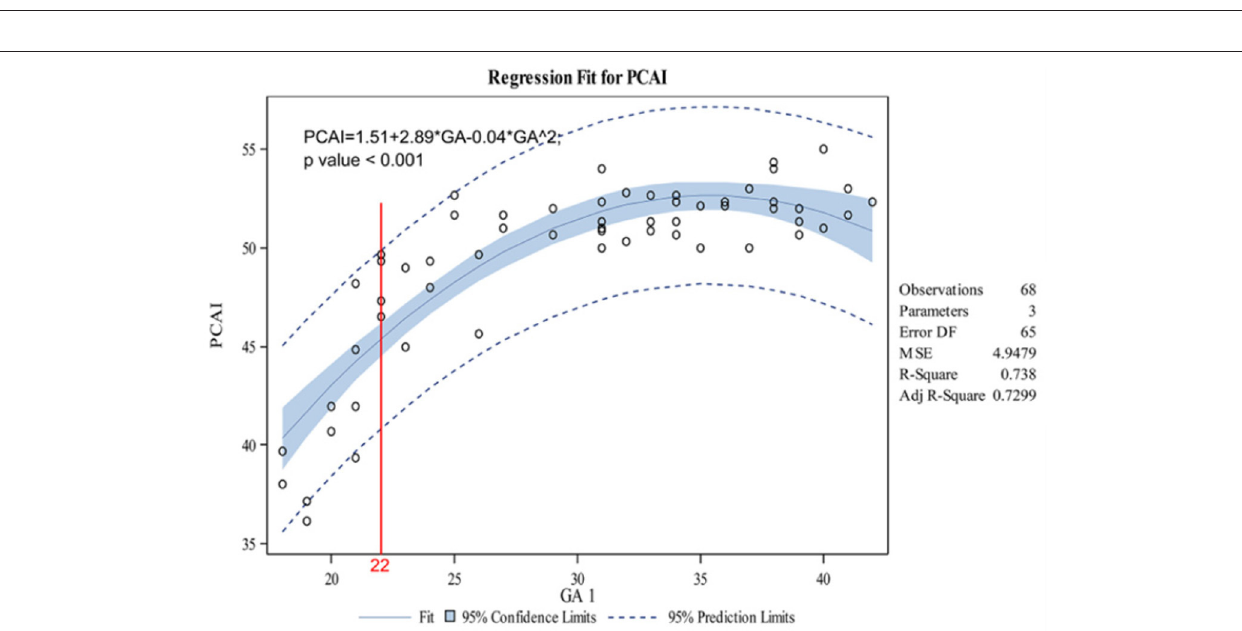
FIGURE 8 | Correlation between gestational age and anterior cartilaginous acetabular index.